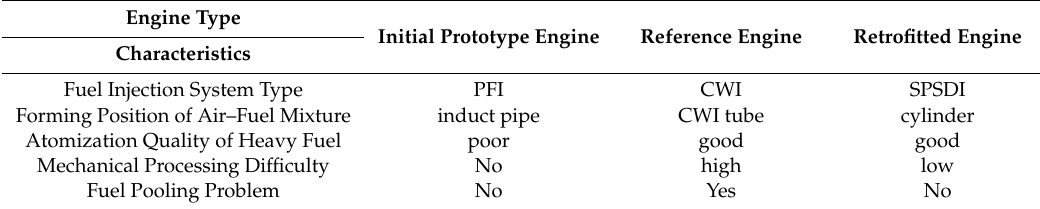
Table 4. Characteristics of all the three types of